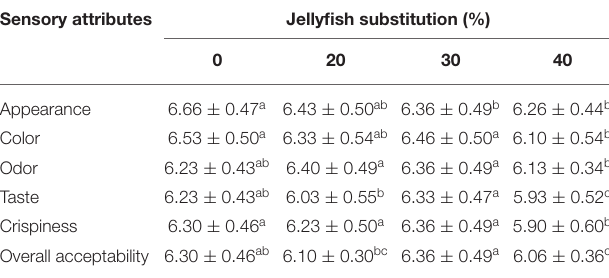
TABLE 4 | Sensory analysis for the overall acceptance of jellyfish crackers*. Sensory